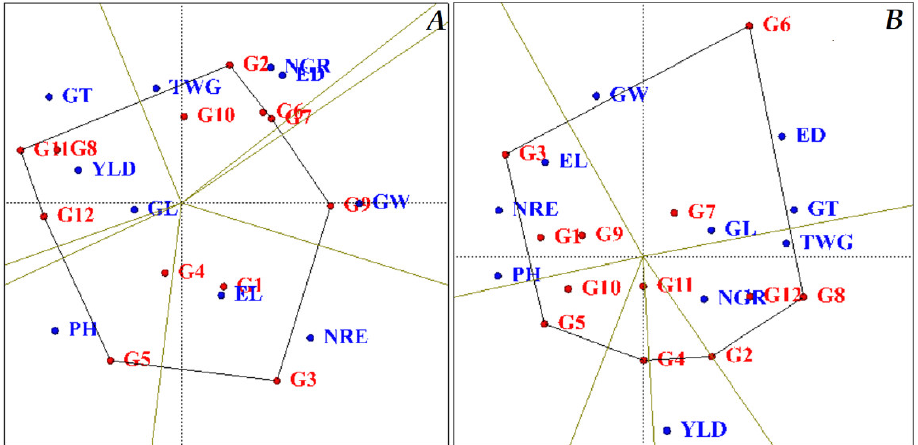
Figure 2. Ranking and Grouping of Genotypes in Terms of Traits. ( A ): normal conditions; ( B ): stress conditions. PH: Plant height, EL: Ear length, ED: Ear diameter, NGR: Number of grains in a row, NRE: Number of rows in-ear, GW: Grain weight, GL: Grain Length, GT: Grain Thickness, TWG: Thousand-grain weight, and YLD: Grain yield. G1: KSC703, G2: KSC260, G3: KSC705, G4: KSC400, G5: KSC706, G6: KSC704, G7: KSC707, G8: DC370, G9: SC647, G10: SC302, G11: SC604, and G12: